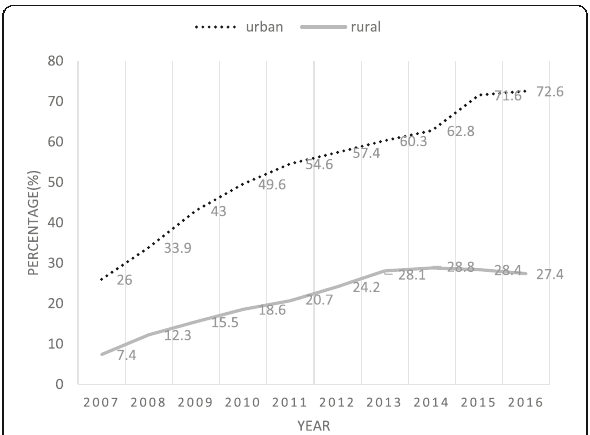
Fig. 4 Internet popularity in urban and rural